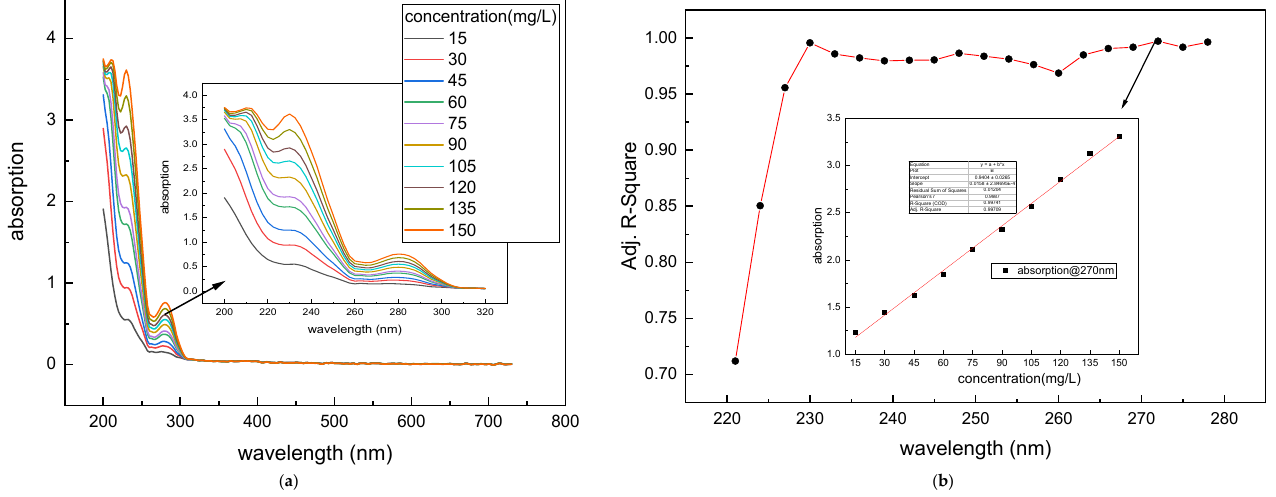
Figure 10. ( a ) Absorption spectrum of COD in concentration from 15 mg/L to 150 mg/L. ( b ) Adjusted R-Square value at the wavelength range of 220 to 280 nm.